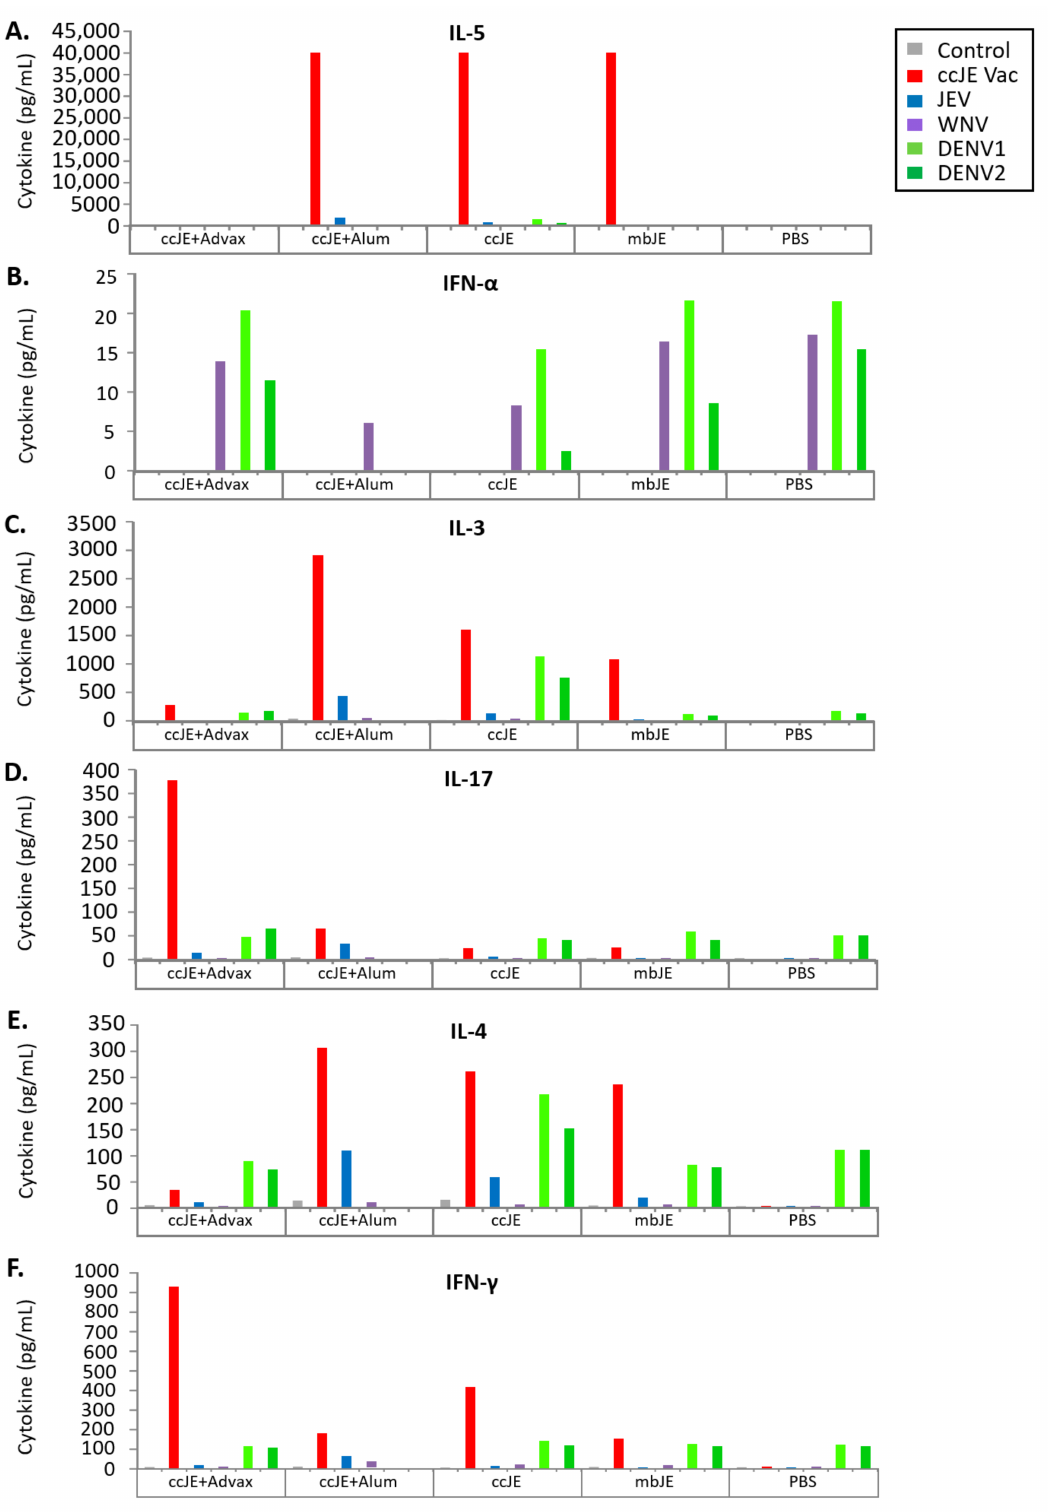
Figure 2. Addition of Advax enhances Th1-associated cytokine production to ccJE vaccine. C57BL/6 mice ( n = 10/group) were immunised and boosted after 3 weeks with ccJE (50 ng) or mbJE (50 ng) alone or formulated with Advax (1 mg) or alum (30 µ g). Spleens were collected 3 week post last immunisation and pooled for each group. Splenocytes were stimulated with ccJE vaccine (1 µ g/10 6 cells) or flaviviruses (JEV, WNV, DENV1 or DENV2) at a MOI of 0.1 for 10 6 cells for 4 days. Cytokines, ( A ) IL-5, ( B ) IFN- α , ( C ) IL-3, ( D ) IL-17, ( E ) IL-4 and ( F ) IFN- γ were measured in culture supernatant using a mouse multiplex immunoassay and a mouse interferon- α ELISA